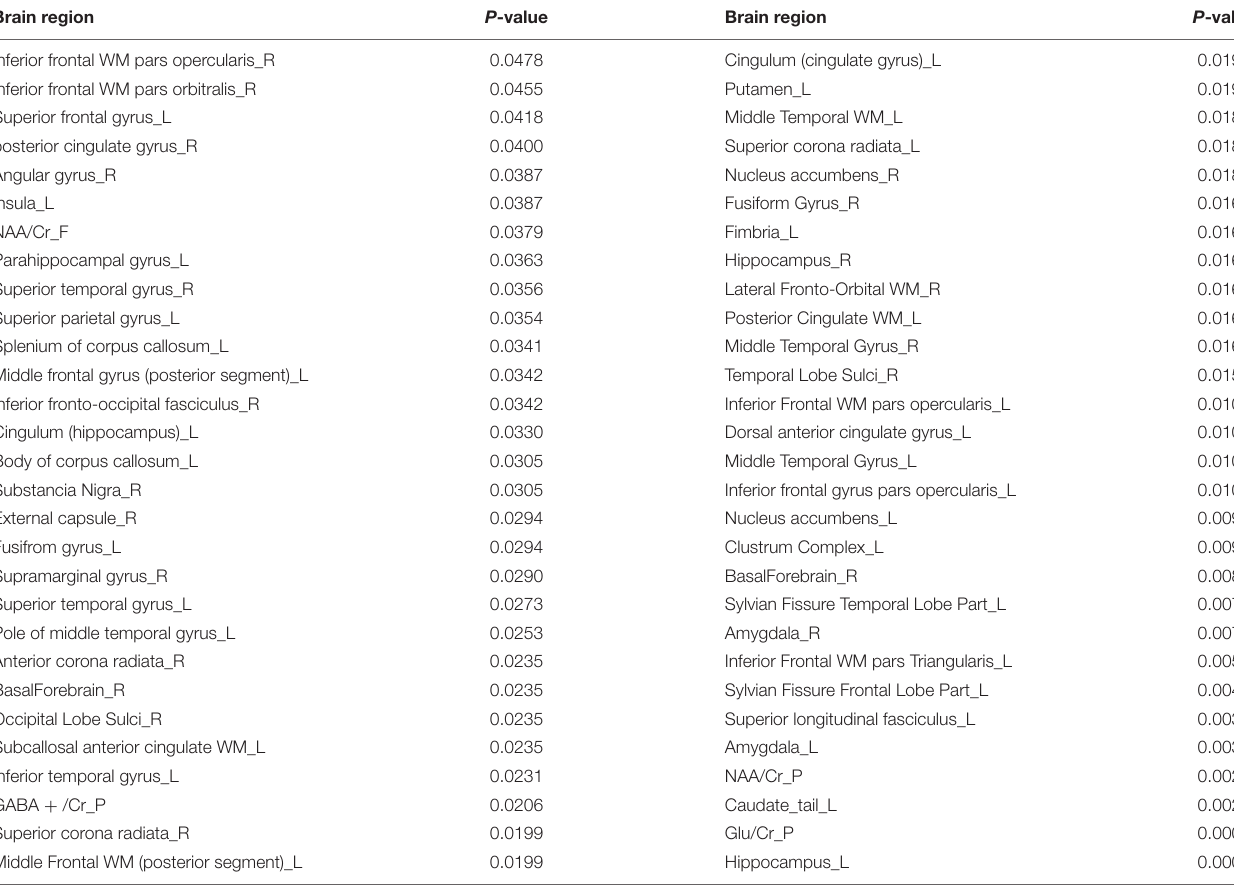
TABLE 2 | Data screened using the t -test. Brain region P